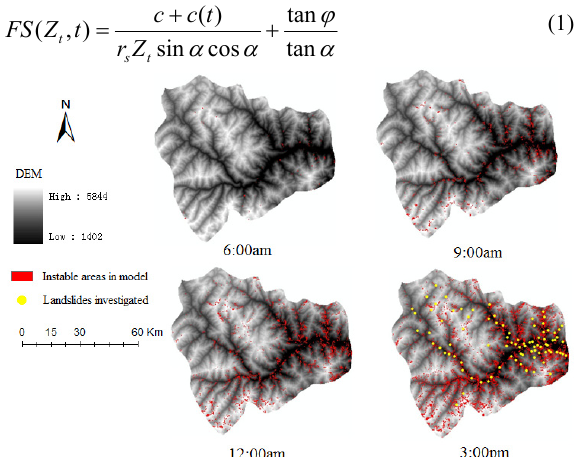
Figure 2 Instability maps of landslides produced by SLIDE model in four periods of Lixian